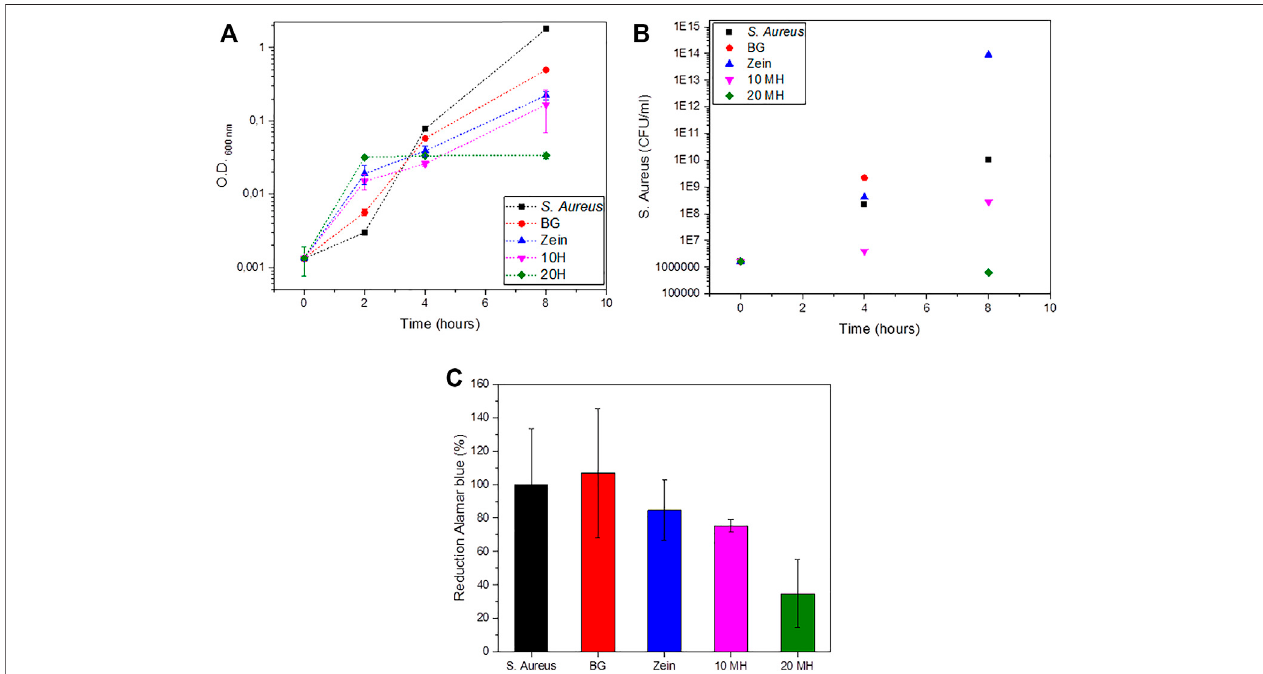
FIGURE 8 | Antibacterial behavior of uncoated and coated BG scaffolds. (A) Turbidity measurements. (B) Colony-forming units of S. aureus . (C) Reduction of Alamar blue after 8 h.